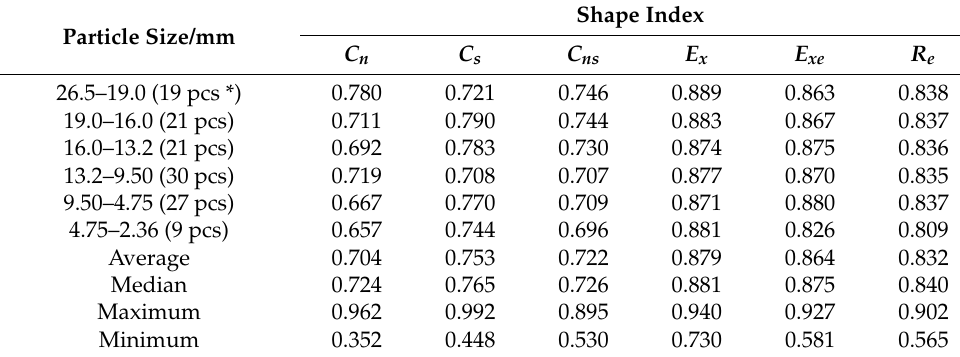
Table 3. Calculation results of typical shape indices of selected